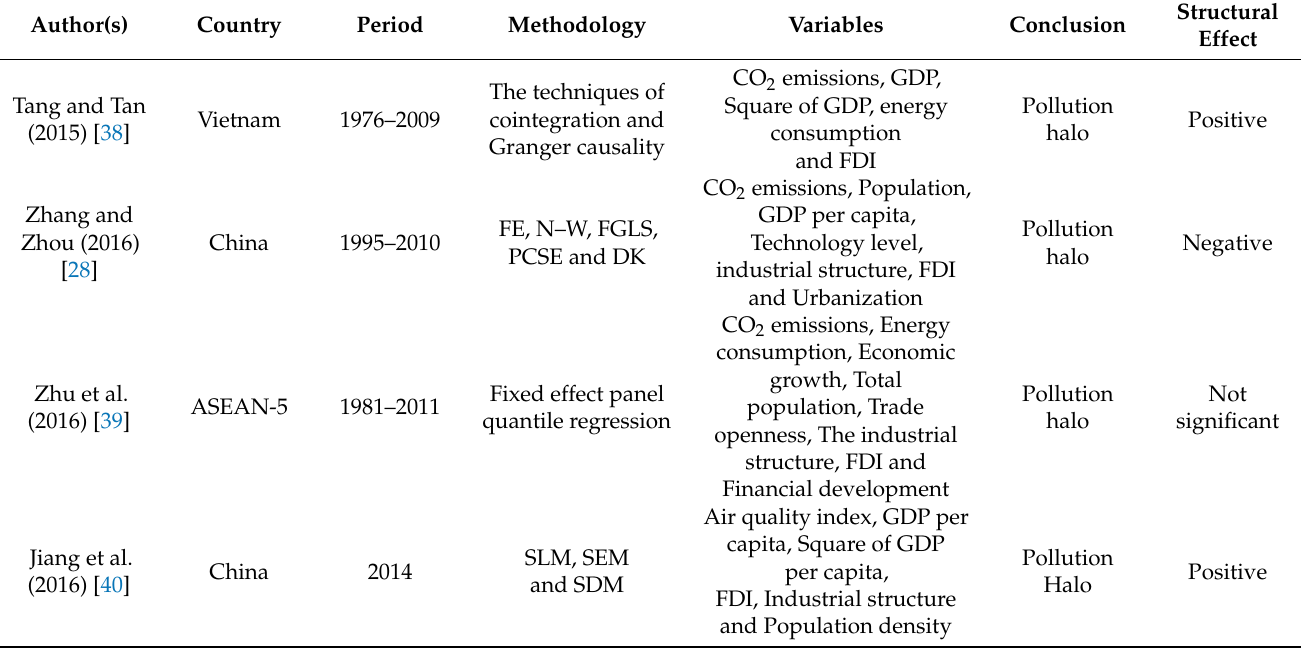
Table 1. Literature